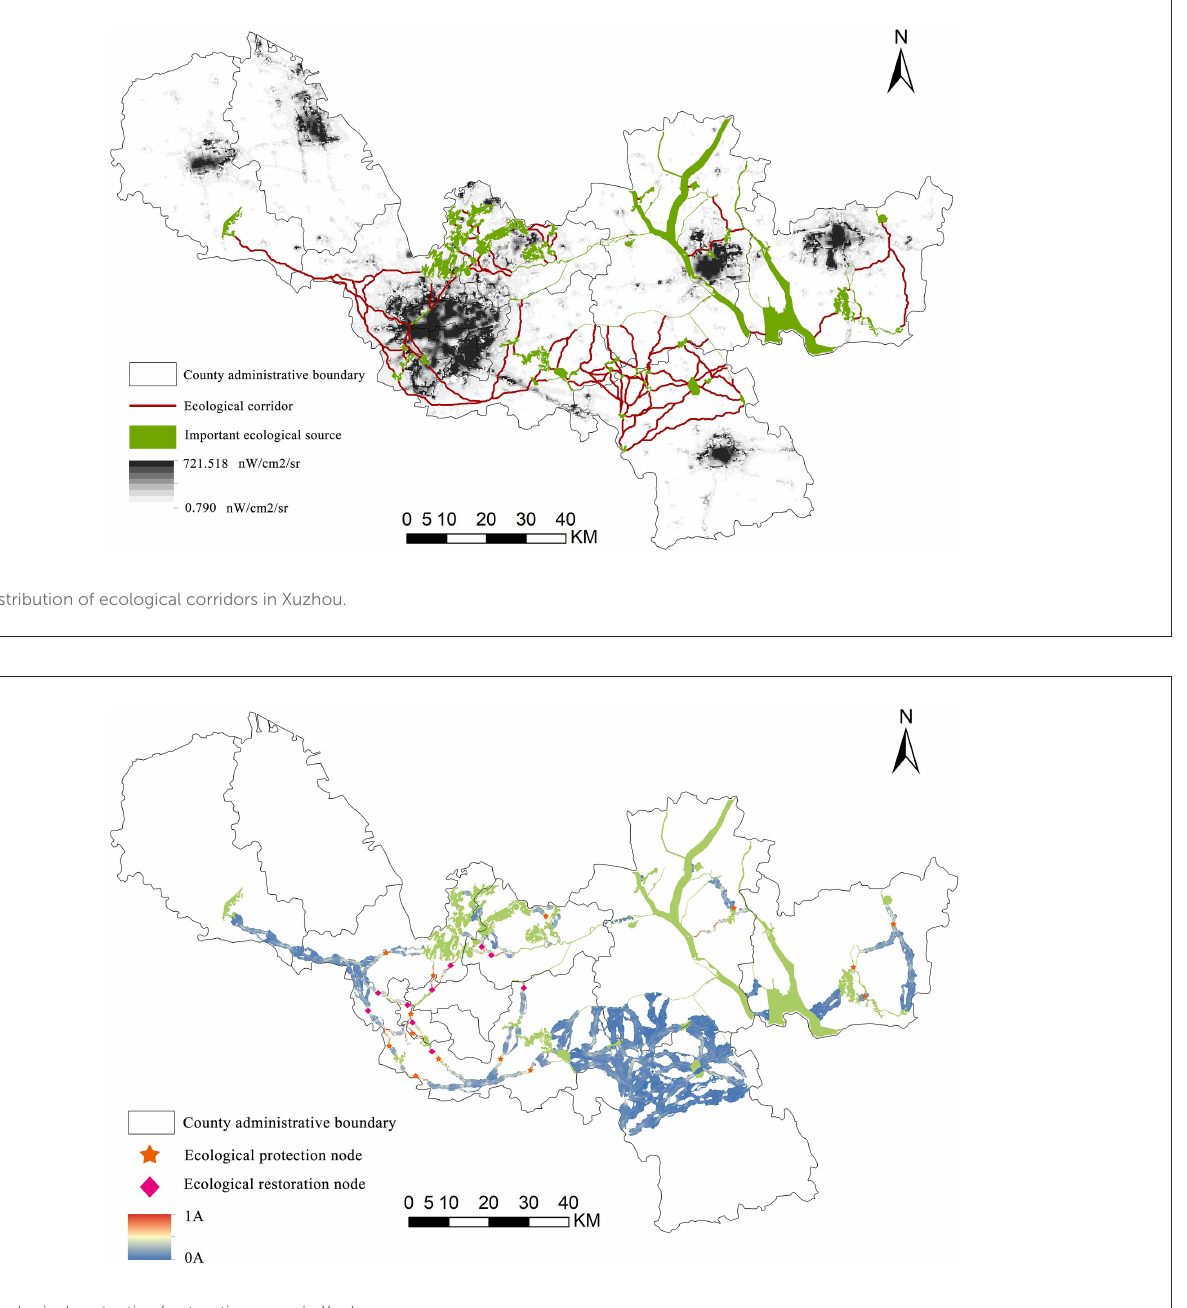
FIGURE7 Critical ecological protection/restoration areas in